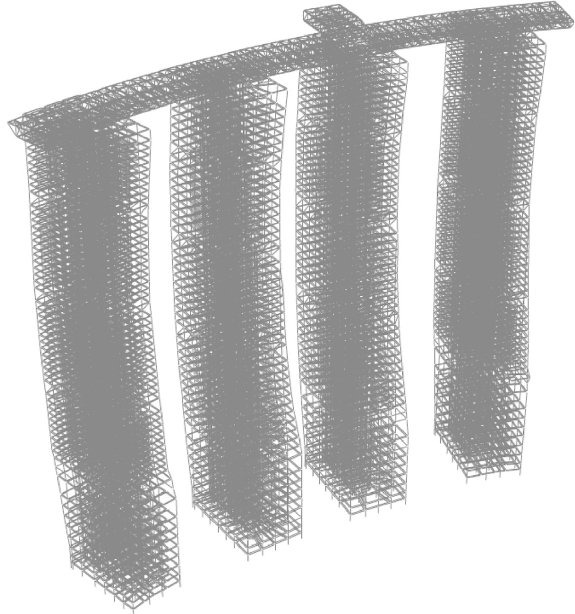
Figure 12: Perform-3D